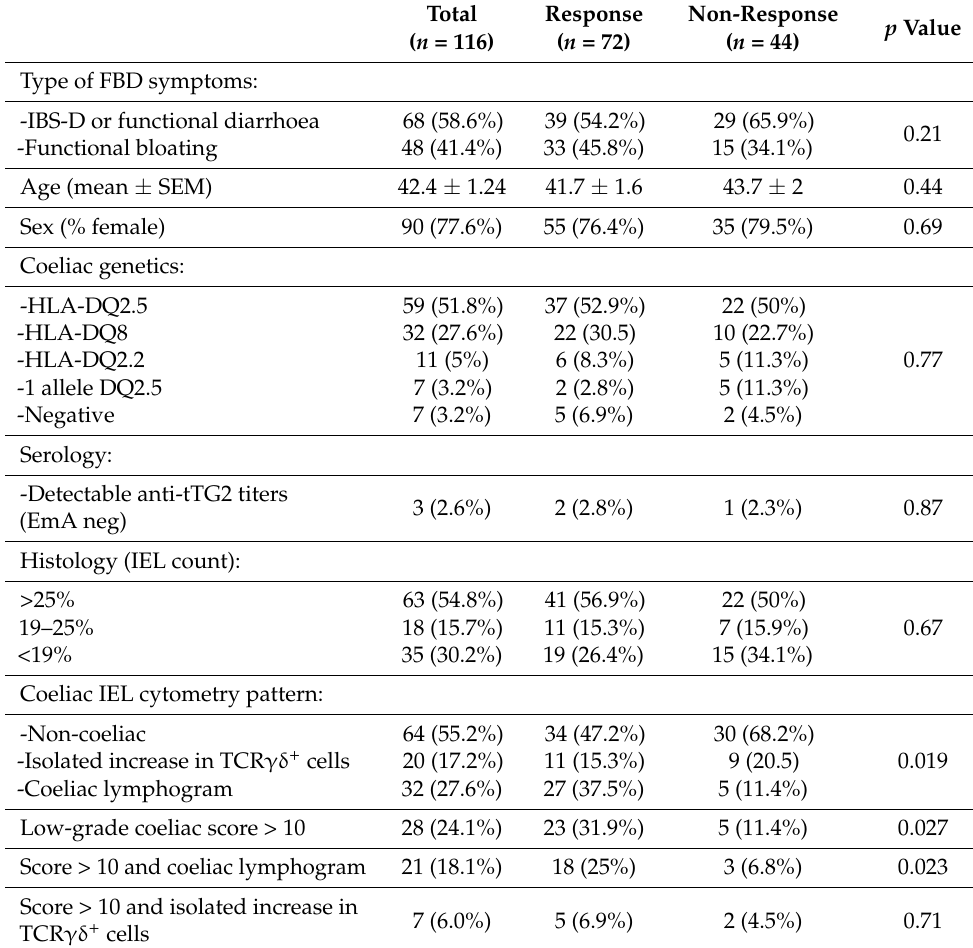
Table 2. Description of patients receiving GFD ( n = 116): comparison of patients in terms of their response to the